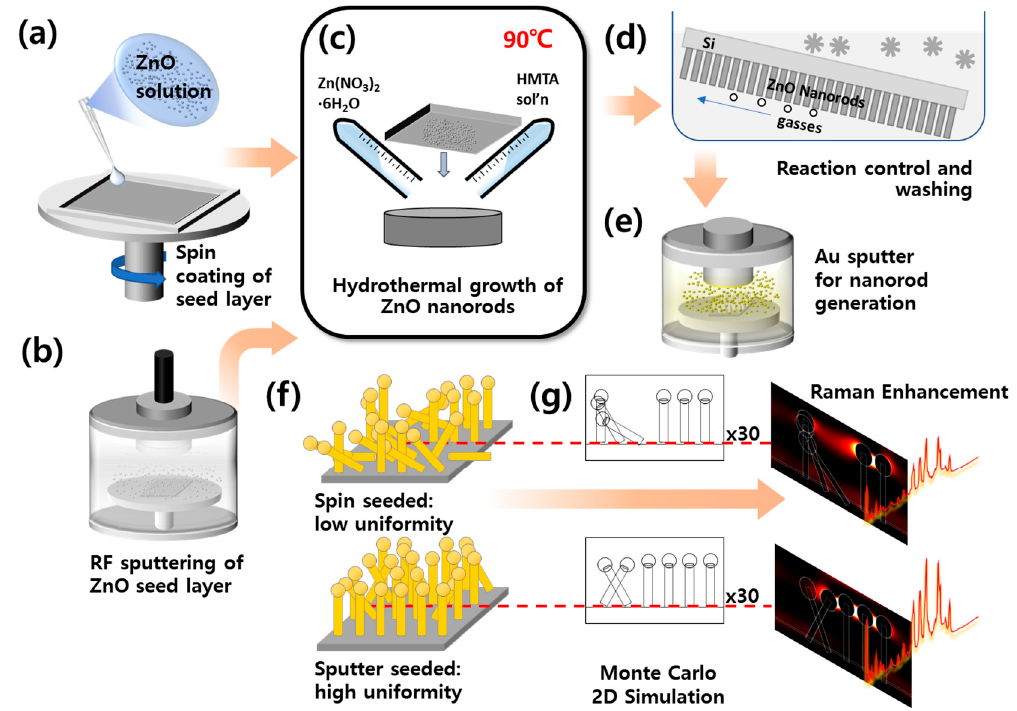
Figure 1. Schematic of the experiment. ( a ) Randomly tilted ZnO nanorods seeded by spin-coating, and ( b ) highly uniform ZnO nanorods seeded by sputtering on Si substrates. ( c ) ZnO grown by a hydrothermal process from zinc nitrate and hexamethylenetetramine (HMTA) solutions. ( d ) Controlled tilt applied to substrates allowing reaction gases to disperse. ( e ) Au-coating by sputtering, leading to plasmonic effects. ( f ) Spun substrates with lower uniformity. ( g ) Raman enhancement in simulations and experiment.